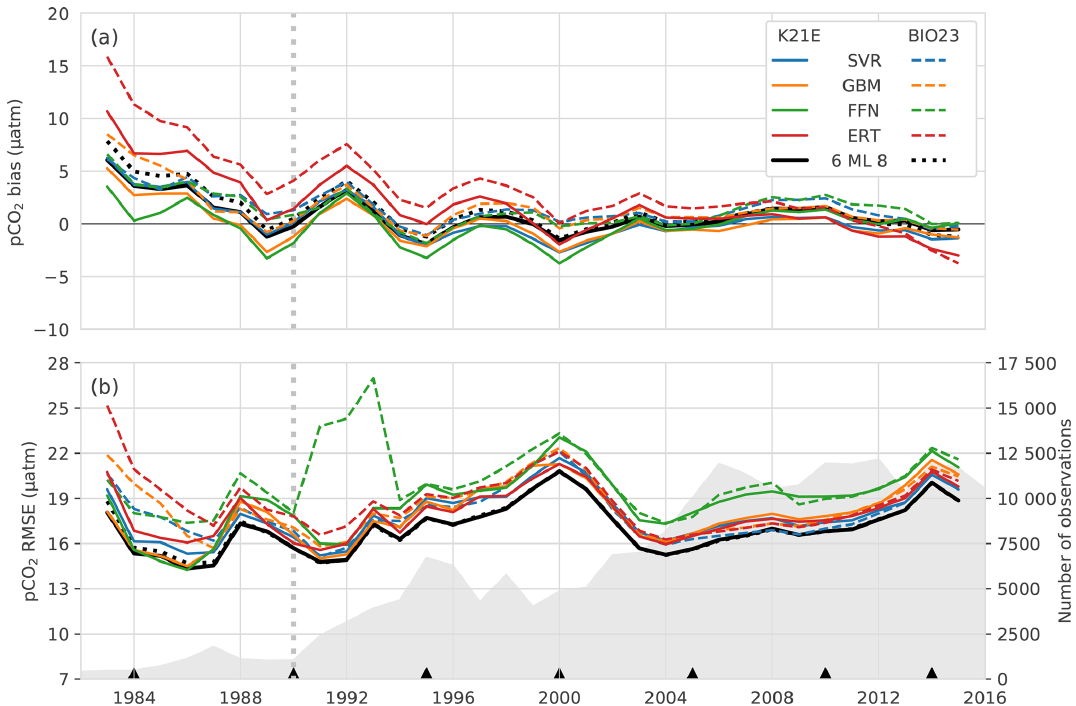
Figure 6. Annually averaged (a) bias and (b) RMSE for the eight individual regression methods in Table 3: BIO23 (dashed lines) and K21E (solid lines). The dotted black lines show the ensemble averages for all eight models (CSIR-ML8), and the solid black line shows metrics for the ensemble average of the SVR, GBM and FFN (CSIR-ML6) from BIO23 and K21E. The grey-filled area in panel (b) shows the number of observations per year, and black triangles show the years that are isolated as the test subset. The vertical dashed grey line demarks 1990, prior to which there is a large positive bias.